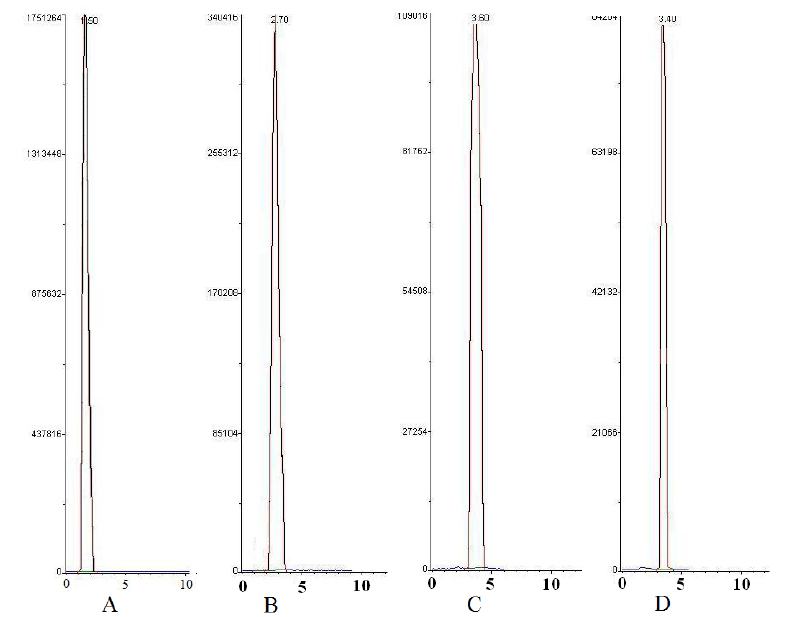
Figure 1. Radio-HPLC chromatograms.